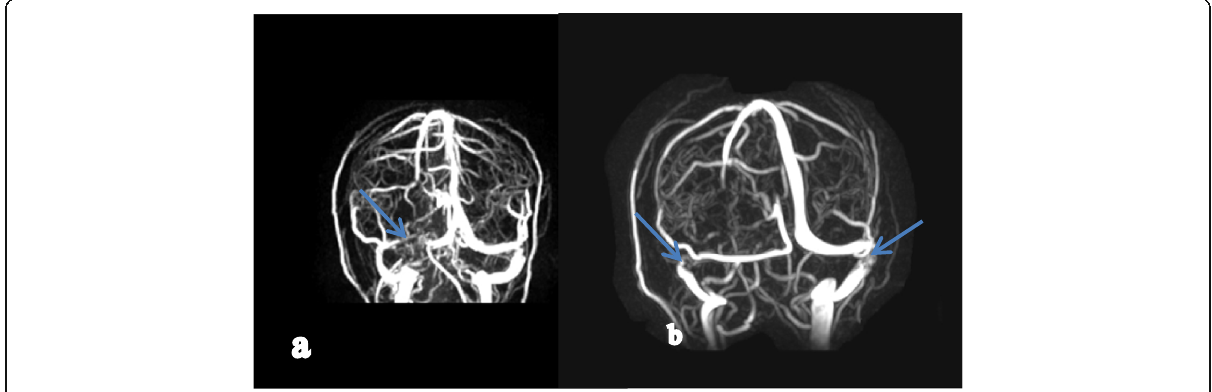
Fig. 8 a Attenuated transverse sinus, b MRV brain showing bilateral stenosis of transverse-sigmoid sinus with hypoplasia of the transverse sinus on the right